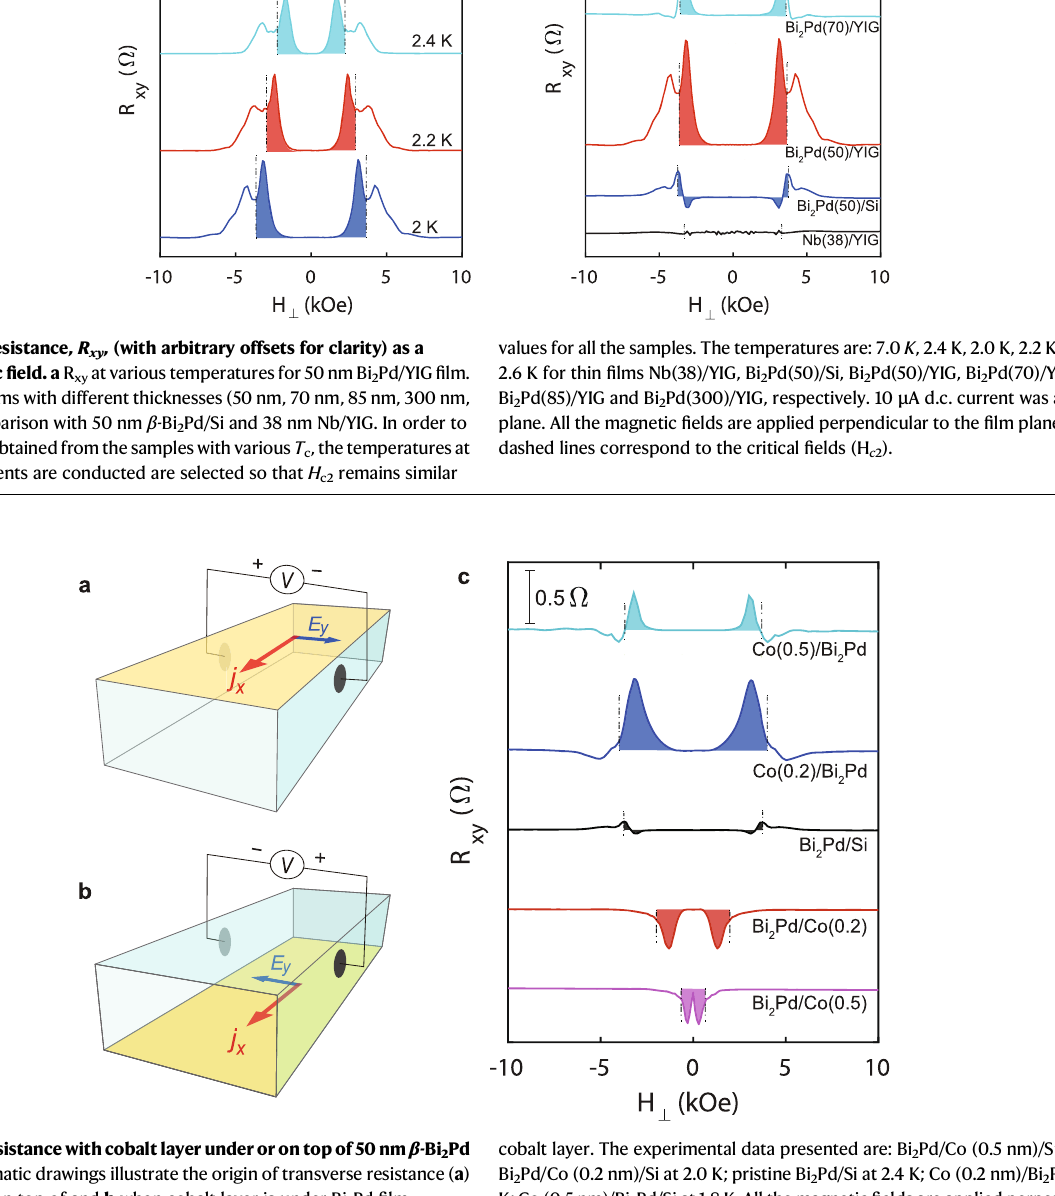
cobalt layer. The experimental data presented are: Bi 2 Pd/Co (0.5 nm)/Si at 1.7 K ; Bi 2 Pd/Co (0.2 nm)/Si at 2.0 K; pristine Bi 2 Pd/Si at 2.4 K; Co (0.2 nm)/Bi 2 Pd/Si at 2.3 K;Co(0.5nm)/Bi 2 Pd/Siat1.8K.Allthemagnetic fi eldsareappliedperpendicularto the fi lm plane. The dot-dashed lines correspond to the critical fi elds ( H c 2 ).